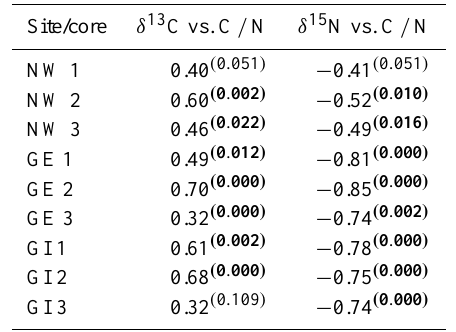
Table 2. Correlation coefficient and p value ( p <0.05 in boldface) between δ 13 C and C / N ratio as well as between δ 15 N and C / N ra- tio for the whole profile at the near-natural (NW), extensively man- aged grassland (GE) and intensively managed grassland (GI) sites at the Ahlen-Falkenberger